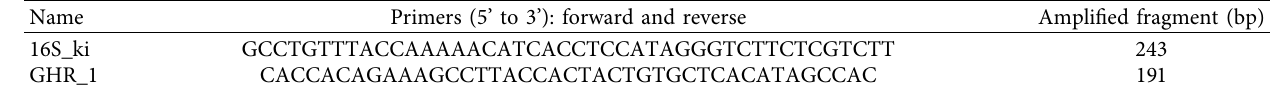
Table 1: Primer pairs used for DNA